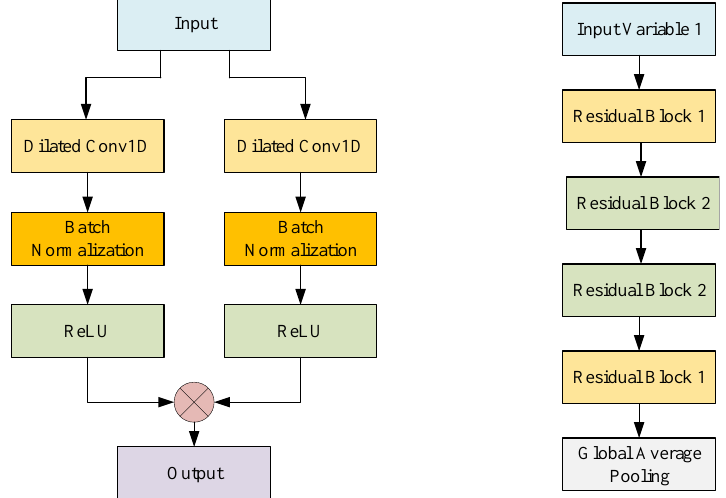
Figure 12. ( left ) Model/w/BN: detail architecture of the Unit. ( right ) Model/r/GAP: the full connection layer is replaced by the global average